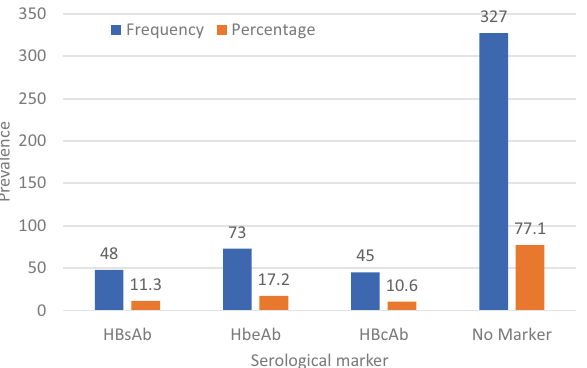
Figure 3. Serological profile of HBsAg negative outpatient study participants attending Kibuku Health Center IV.